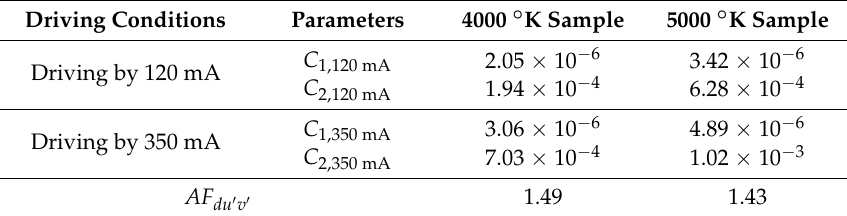
Table 4. Parameters of the linear color shift model.